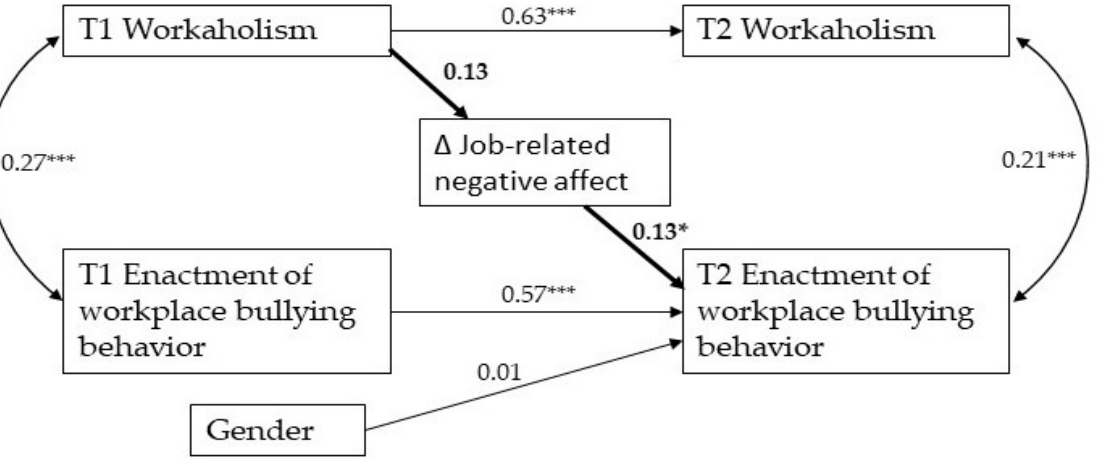
Figure 2. Path analysis in Model 4 of the cross-lagged relationships between workaholism, job-related negative affect, and enactment of workplace bullying behavior. * p < 0.05, *** p < 0.001.